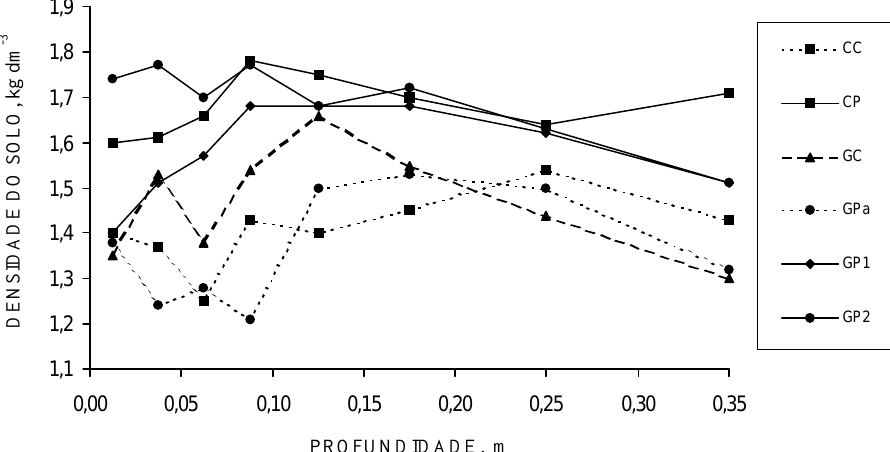
Figura 1. Densidade do solo para as seis trincheiras